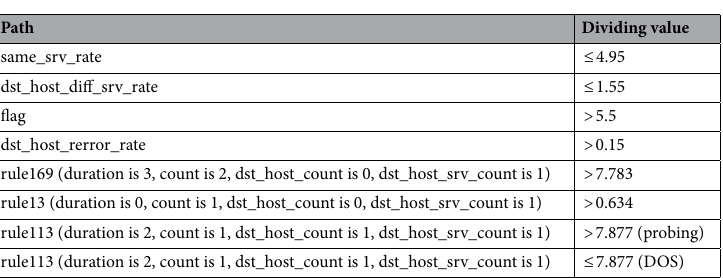
Table 8. The classification pattern of the nodes. 0–3 represent which fuzzy interval the attribute will be calculated in.